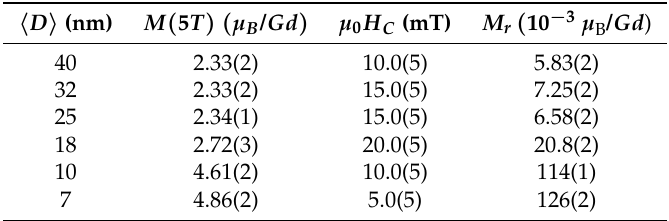
Figure 5. ( a ) Magnetic moment per Gd atom M ( µ B / Gd at) vs. external applied field µ 0 H (hysteresis loop) measured at T = 5 K for the GdCu 2 NPs. Left inset: Zoom of the central region µ 0 H ∼ mT to better see the coercive field µ 0 H C and remanent magnetisation M r . Right inset: M ( µ 0 H ) for the bulk ( t = 0 h) alloy measured up to µ 0 H = 9 T. ( b ) Evolution of the µ 0 H C (red spheres) and M (5T) (blue squares) with the mean diameter (cid:104) D (cid:105) of the NPs measured at T = 5 K. Table 3. Magnetic moment at µ 0 H = 5 T M ( 5 T ) , coercive field µ 0 H C and remanent magnetic moment M r for GdCu 2 NPs measured at T = 5